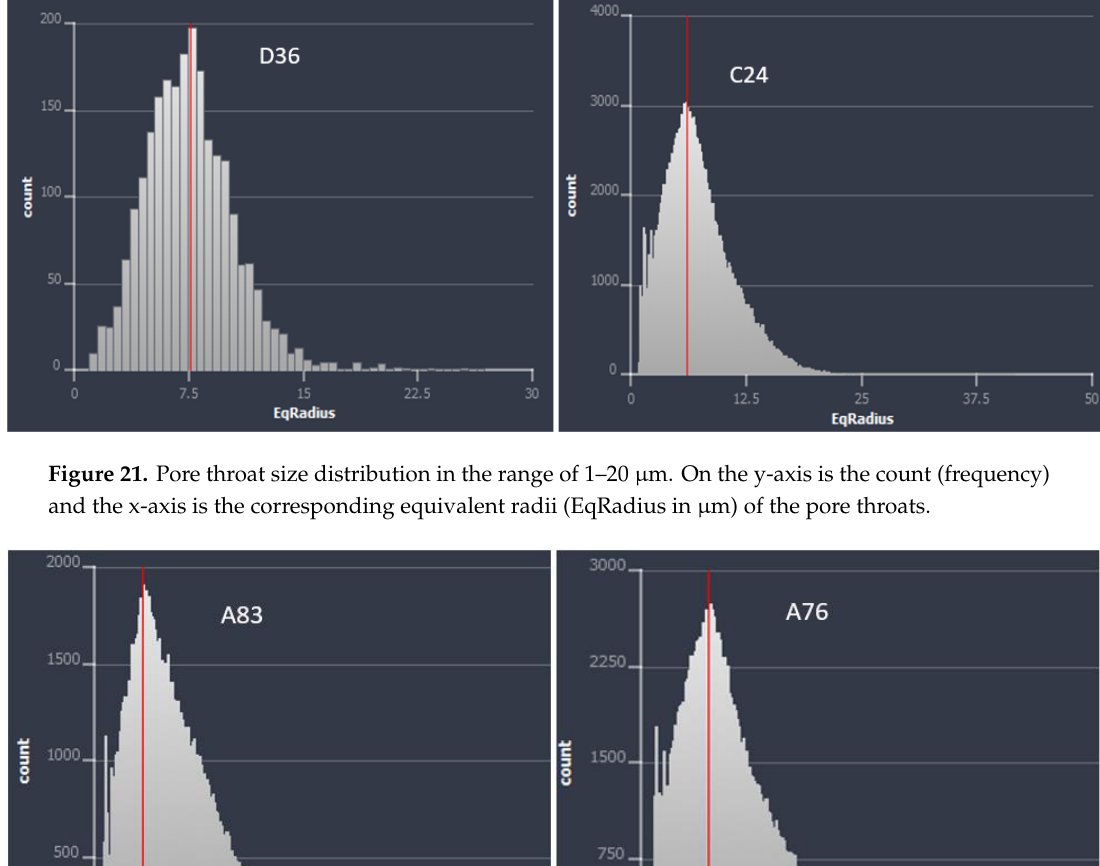
Figure 20. High-resolution µCT images and their segmentation for samples in group 2 (>7% porosity). CT images taken at 4-µm resolution.